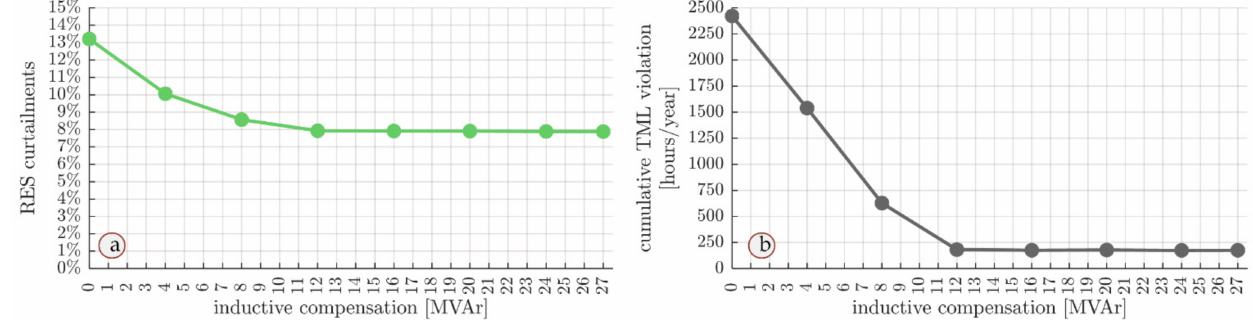
Figure 8. ( a ) RES curtailments and ( b ) annual hours of thermal unit TML violations, as a function of reactor capacity in the power system of